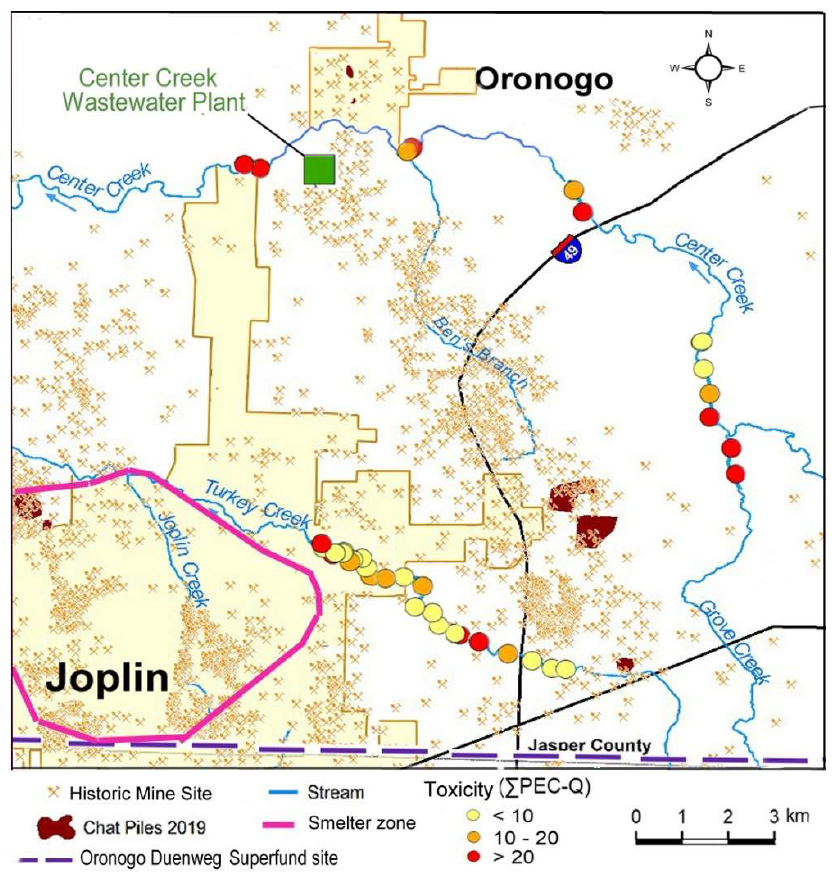
Figure 3. Location and areal coverage of remaining chat piles (as of 2019) and metal toxicity in stream sediments (∑PEC-Q Cd,Pb,Zn ) based on Cd, Zn, and Pb concentrations. Both Turkey Creek and Center creek are flowing northwest towards the Spring River.